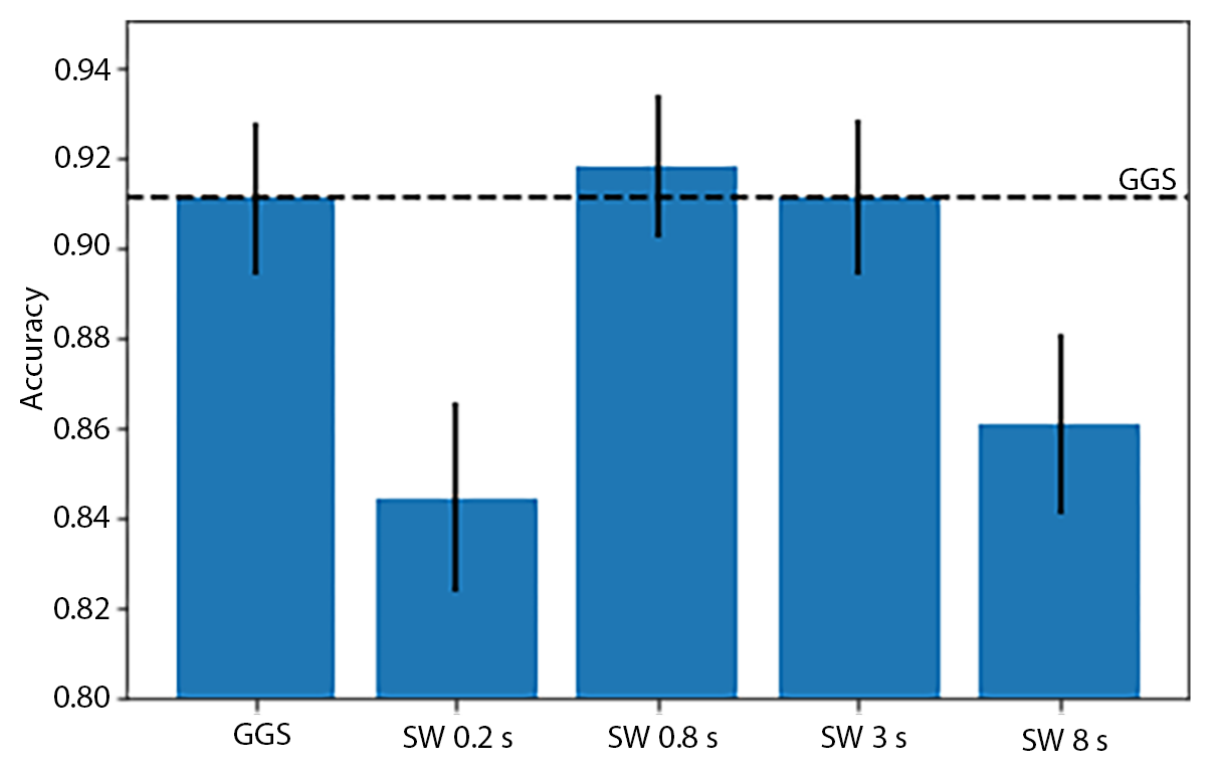
Figure 7. Accuracy of instantaneous predictions using 4 different fixed-size sliding windows (SWs) in the 6 test experiments in the human activity recognition using smartphones dataset. The horizontal dashed line represents the accuracy using greedy Gaussian segmentation. GGS: greedy Gaussian